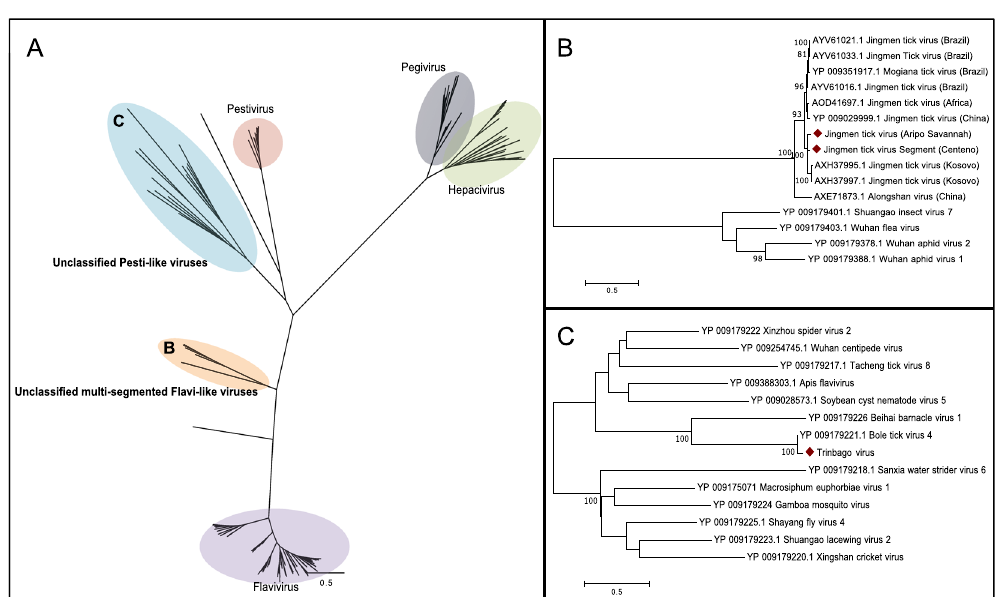
Figure 6. Phylogenetic relationships of Flaviviridae based on an alignment of a 655-aa conserved region of the NS5. ( A ) Phylogenetic tree of all species belonging to Flaviviridae . ( B ) Close up view of the unclassified multi- segmented Flavi-like group. ( C ) Close up view of the unclassified Pesti-like